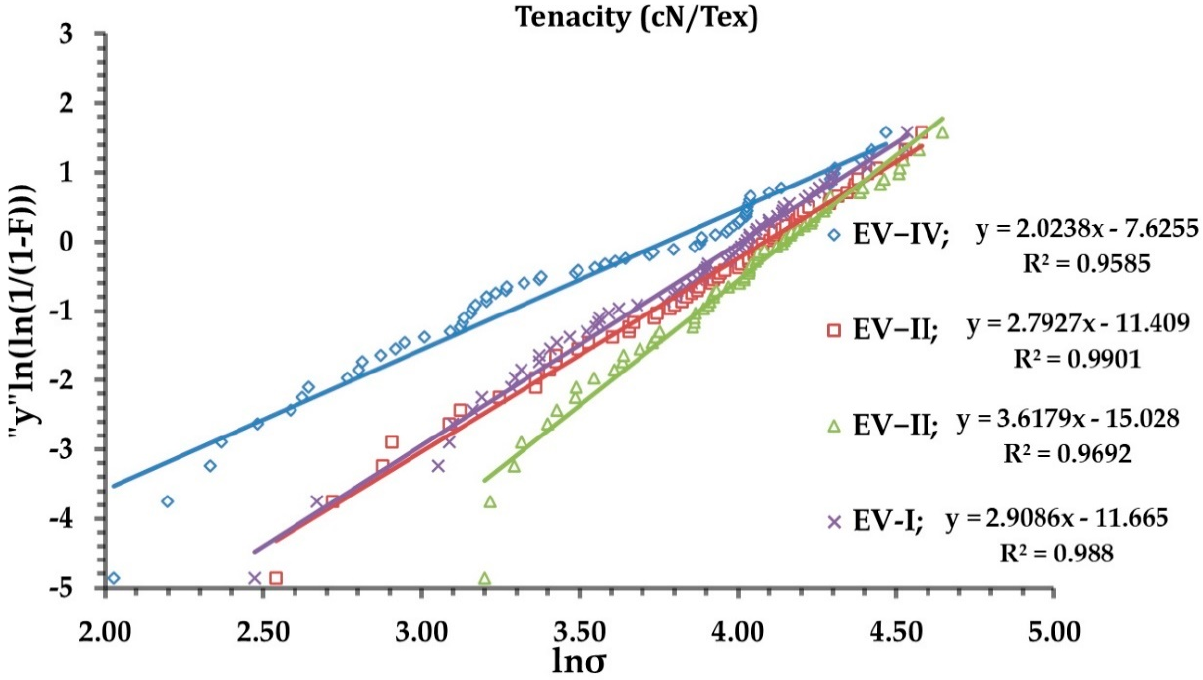
Figure 10. The Weibull plots of Enset fiber tenacity at each fiber portion in specific EV-IV (1125–1500).